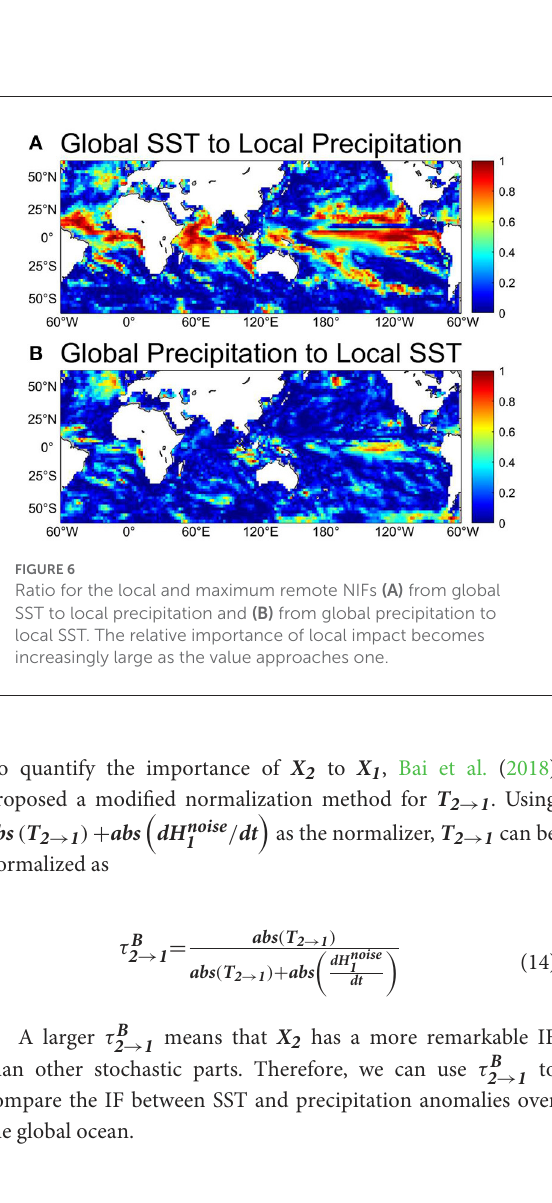
FIGURE5 Maximum remote NIFs (A) from global SST to local precipitation and (B) from global precipitation to local SST.